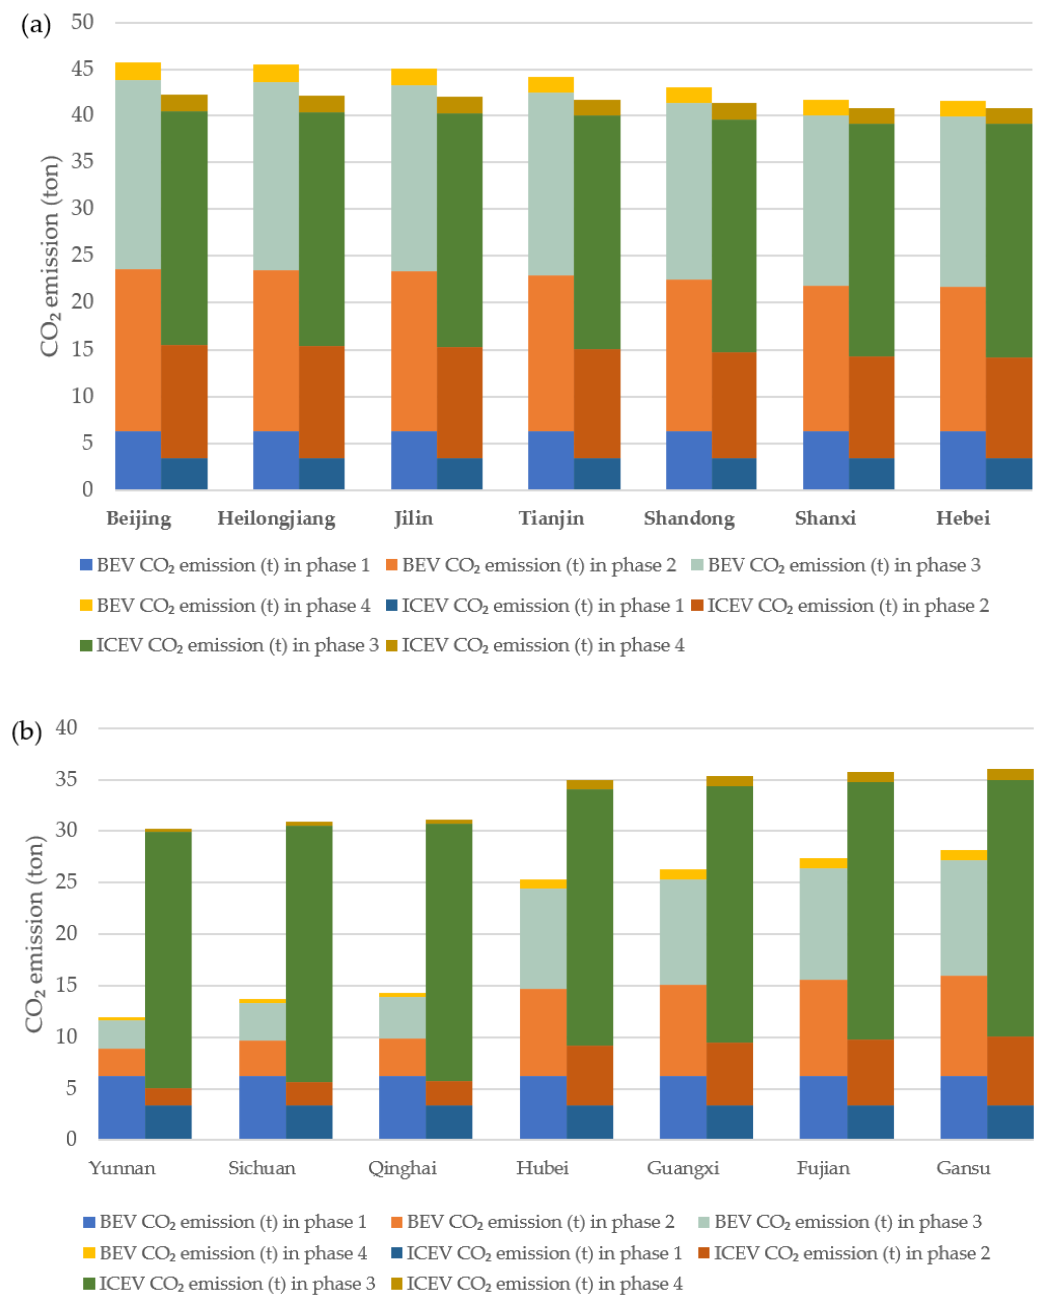
Figure 6. CO 2 emissions of ICEVs and BEVs in four phases of LCA in 14 selected regions (phase 1 stands for material extraction and processing, phase 2 stands for vehicle manufacturing, phase 3 stands for vehicle use, and phase 4 stands for vehicle recycling). ( a ) seven regions with a high proportion of thermal power. ( b ) seven regions with a low proportion of thermal